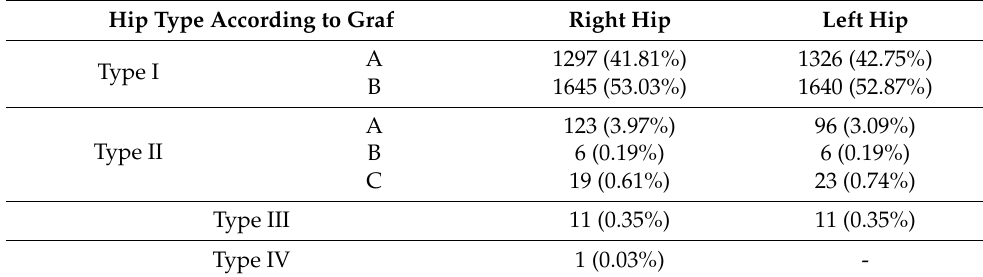
Table 3. Hip type according to Graf in study participants.